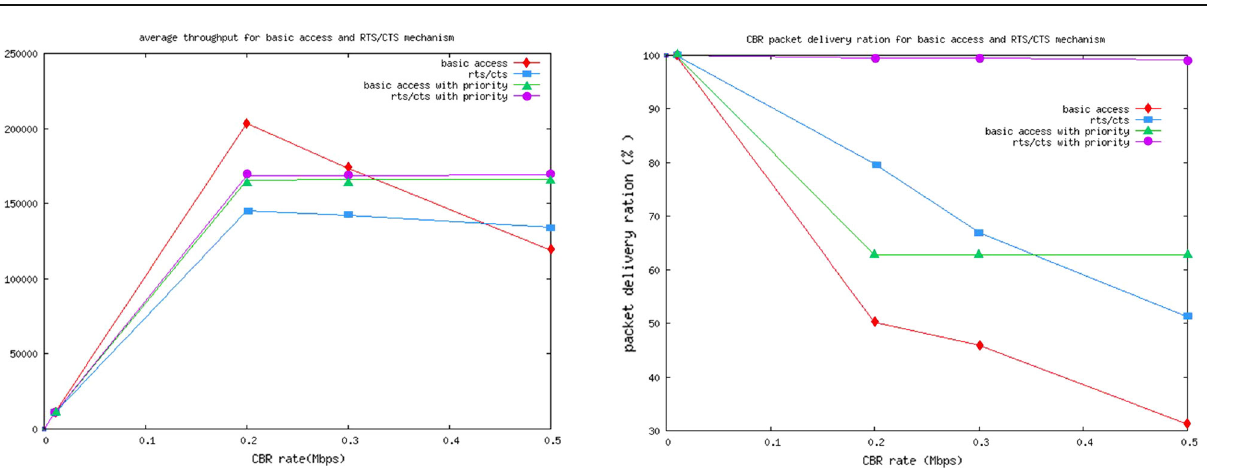
Fig. 4 End-to-end throughput in the 7-nodes chain topology Fig. 5 Packet delivery ration in the 7-nodes chain topology